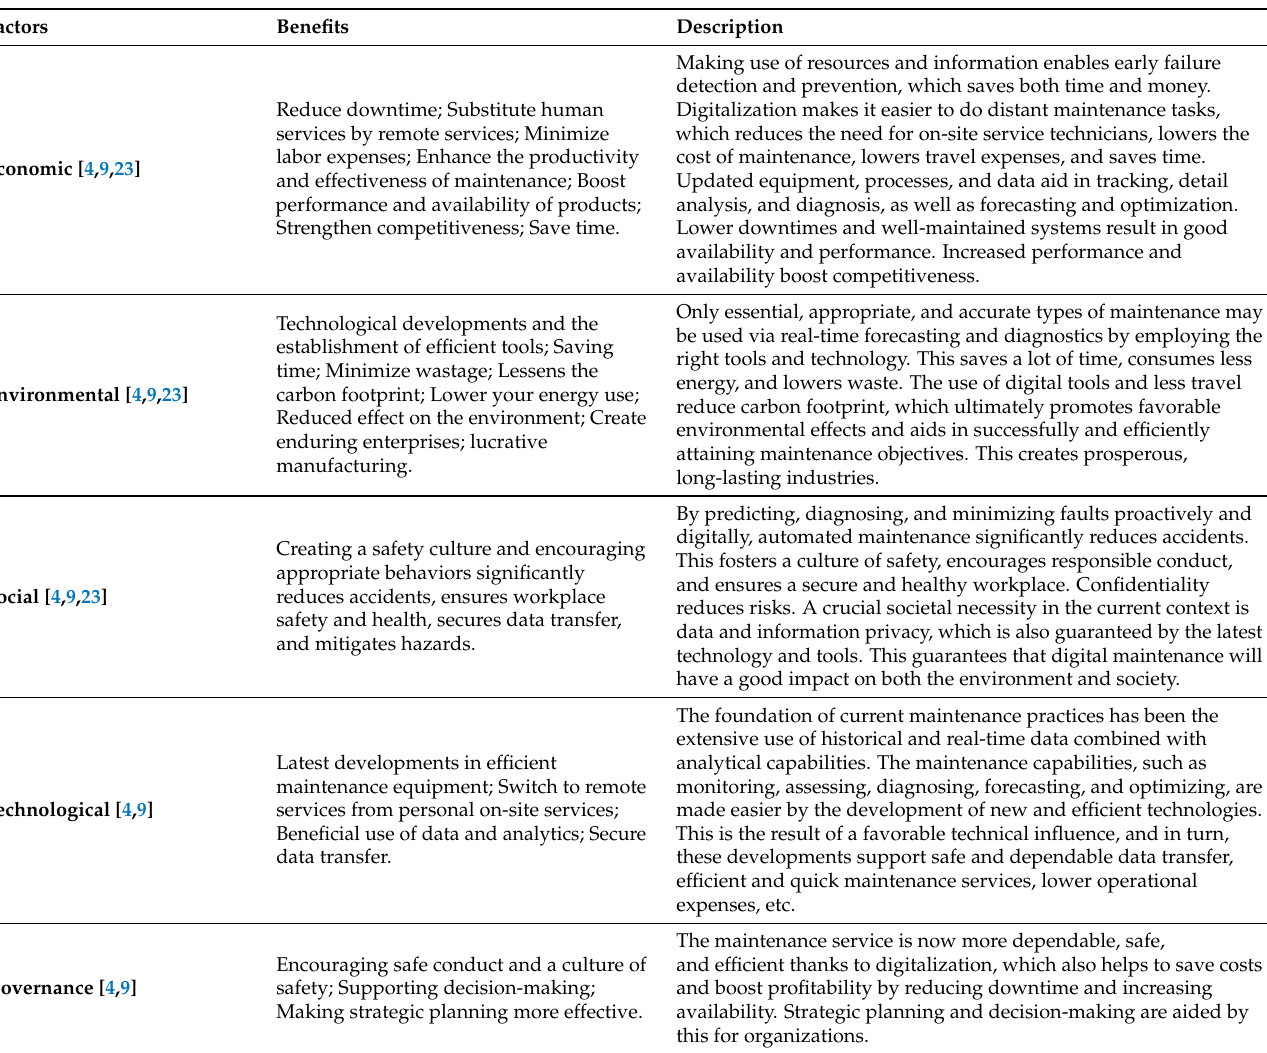
Table 1. Benefits of digitalization in maintenance management